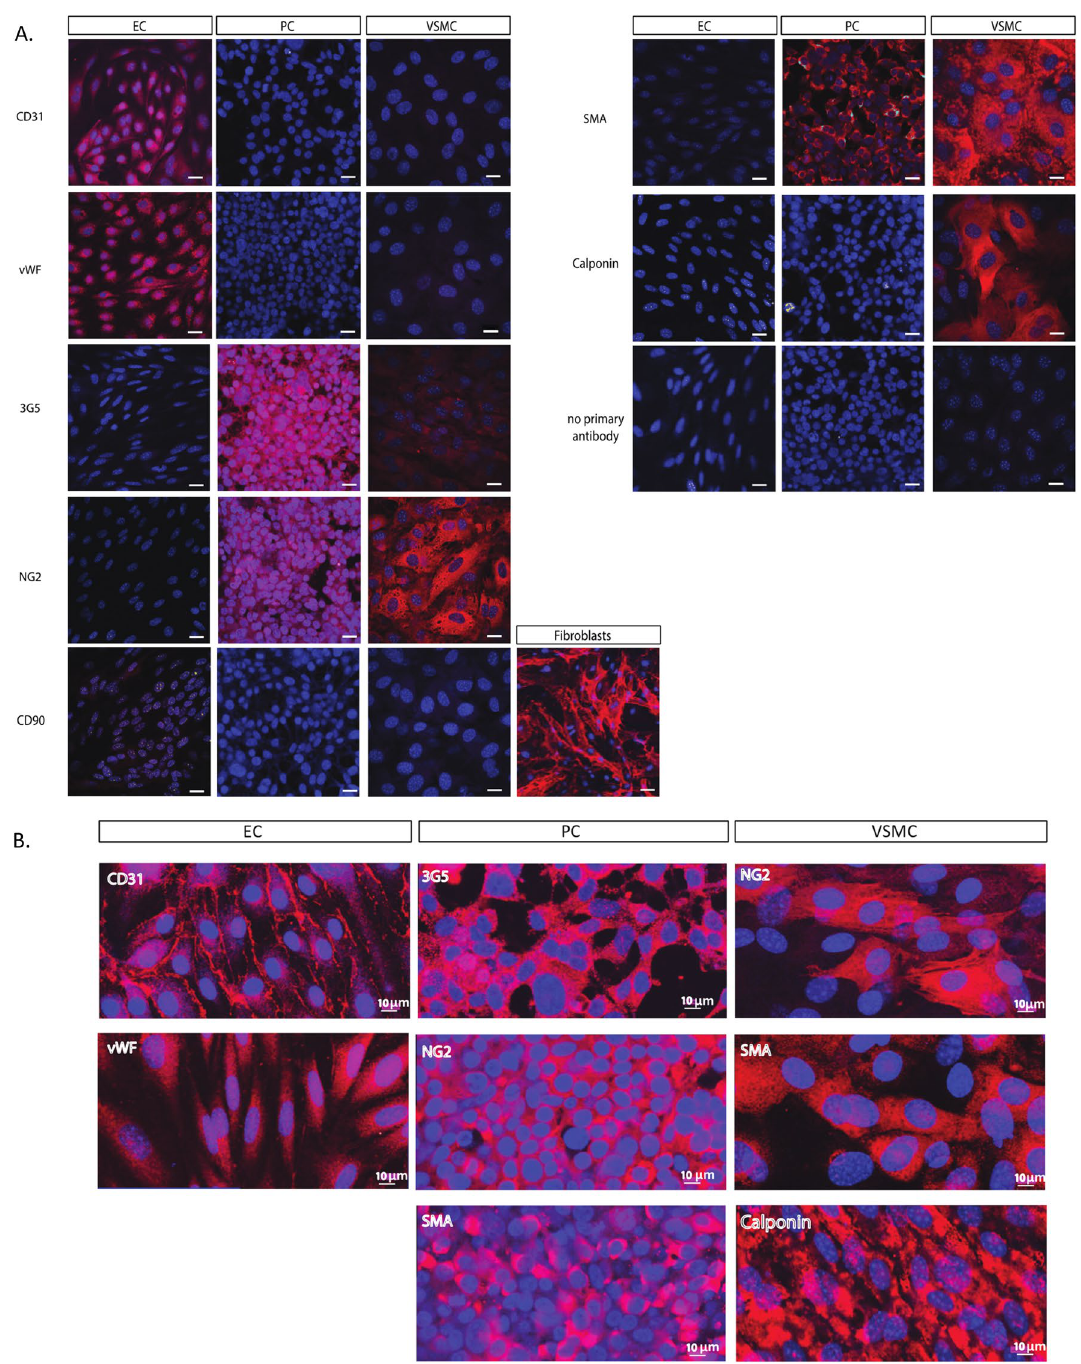
Figure 3. Immunocytochemical validation of heart ECs, PCs, and VSMCs. ( A ) Immunolabeling of ECs (first column), PCs (middle column) and VSMCs (last column) with antibodies against typical cell markers: CD31, PDGFR-β, vWF, 3G5 ganglioside, NG2, SMA and calponin, all in red. Cells are counterstained with Hoechst 33342 (blue). Cells were also immunolabeled with anti-CD90, present in fibroblasts, but not in EC, PC, or VSMC cultures. Scale bar, 20 µm. ( B ) High magnification of cell-specific markers, scale bar, 10